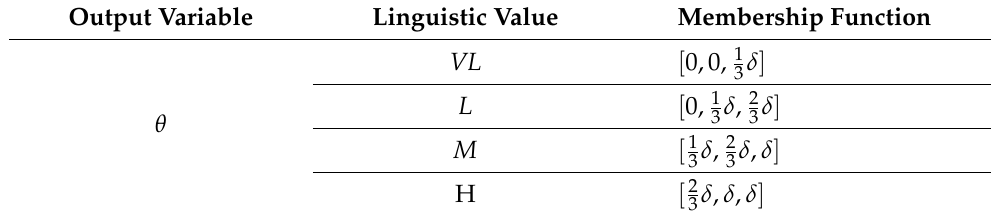
Table 3. Output variable with its linguistic values and membership function, δ =